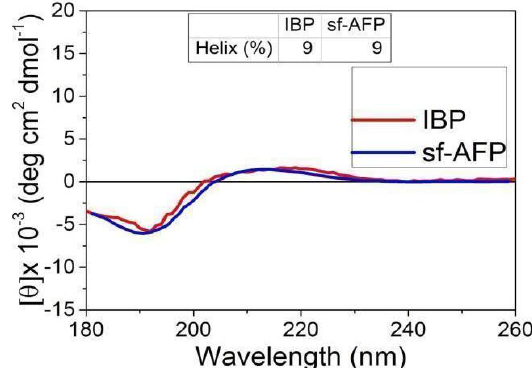
Figure 7. Circular dichroism spectroscopy data of the ice-binding protein (IBP) fraction obtained in the current study and the snow flea 6.5 kDa antifreeze protein reported by [7].